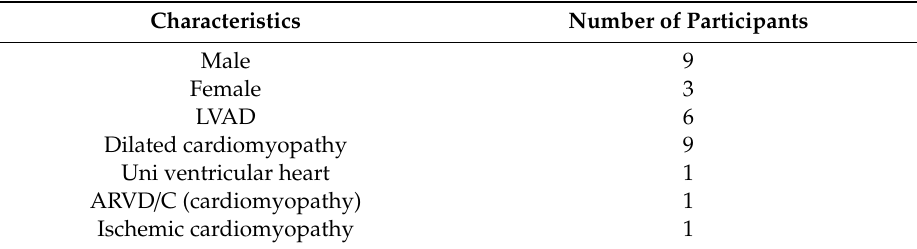
Table 1. Patient characteristics (n = 12).